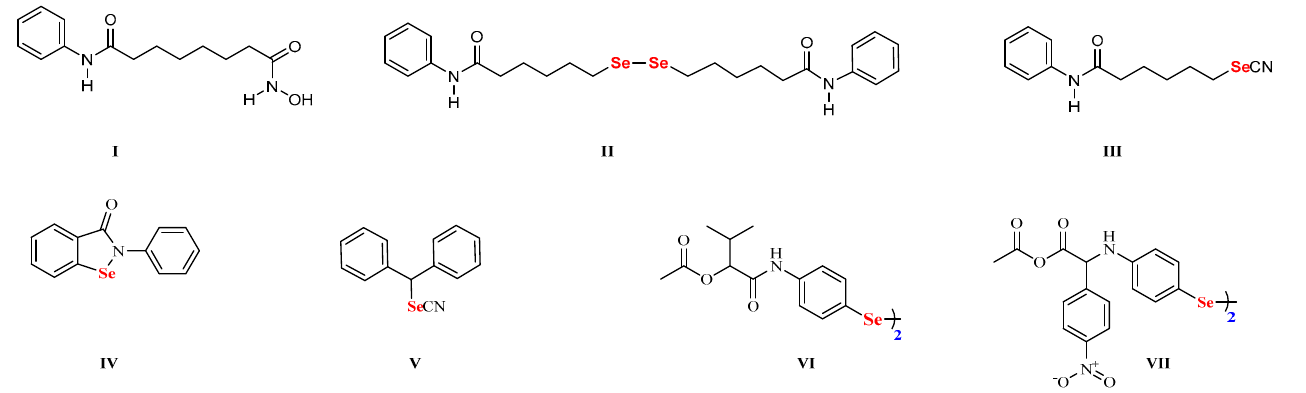
Figure 3. Diverse organoselenium compounds.